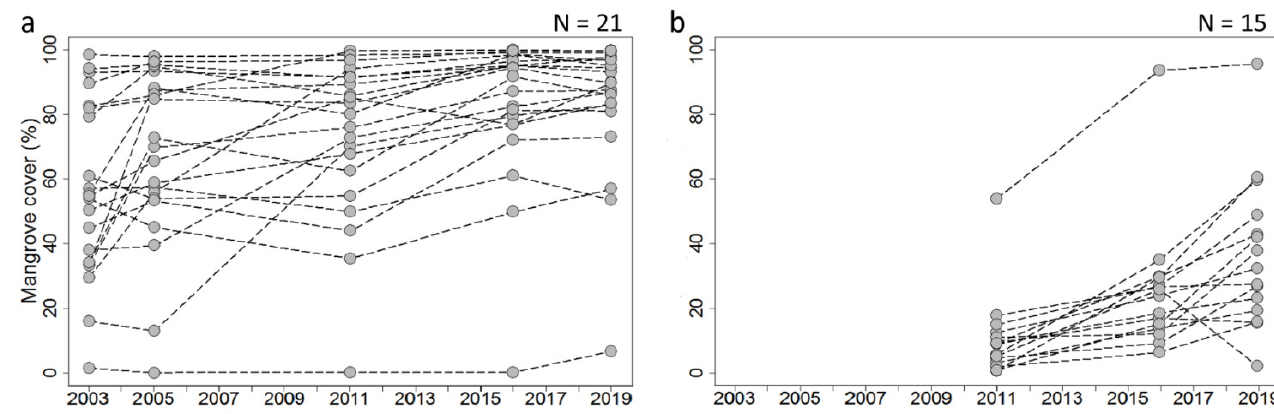
Figure 9. Changes in the mangrove cover (% relative to fishbone area) within individual fishbone plots implemented prior to or in ( a ) 2003 and ( b ) between 2005 and 2011.